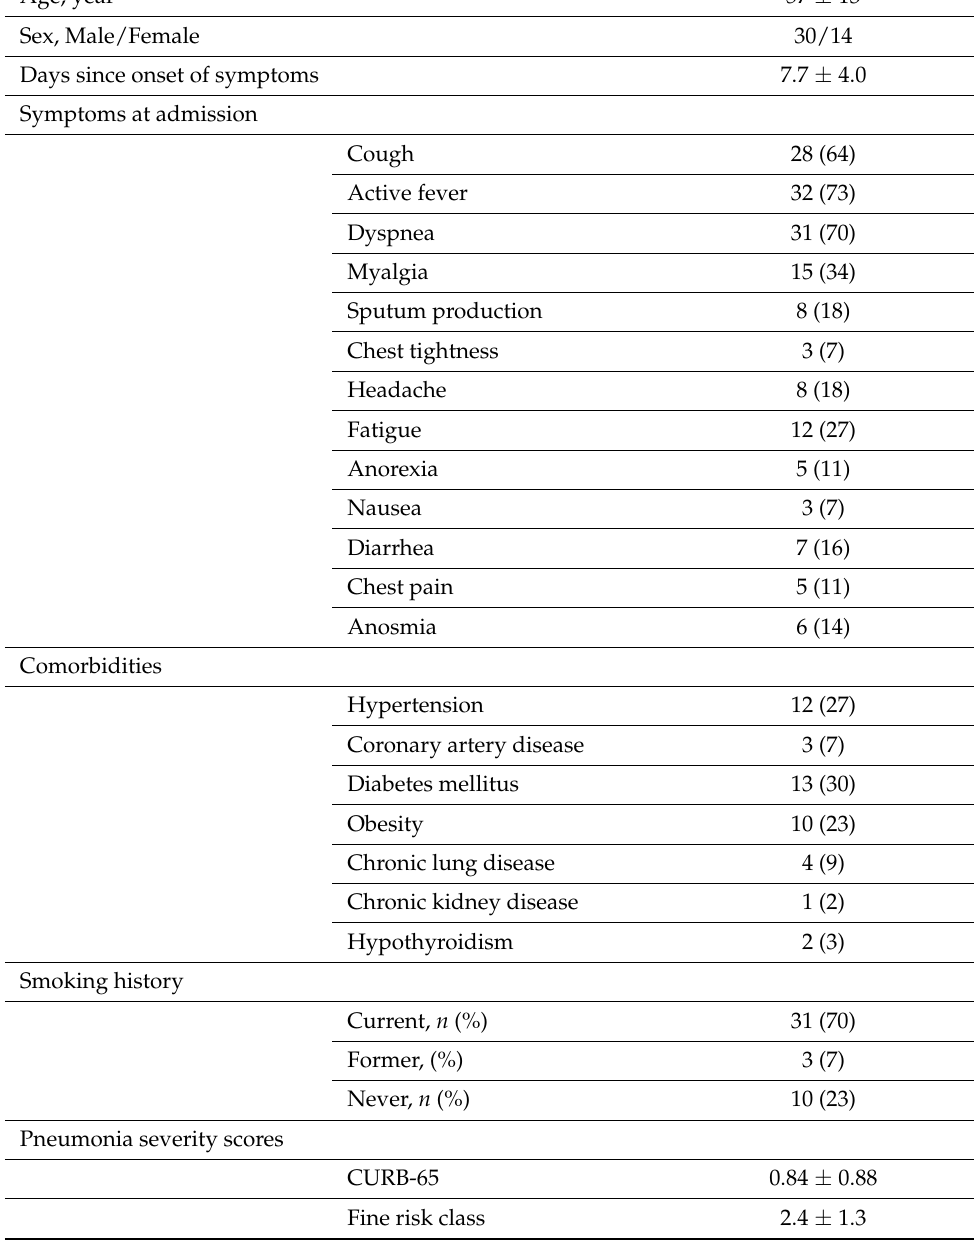
Table 1. General characteristics of the